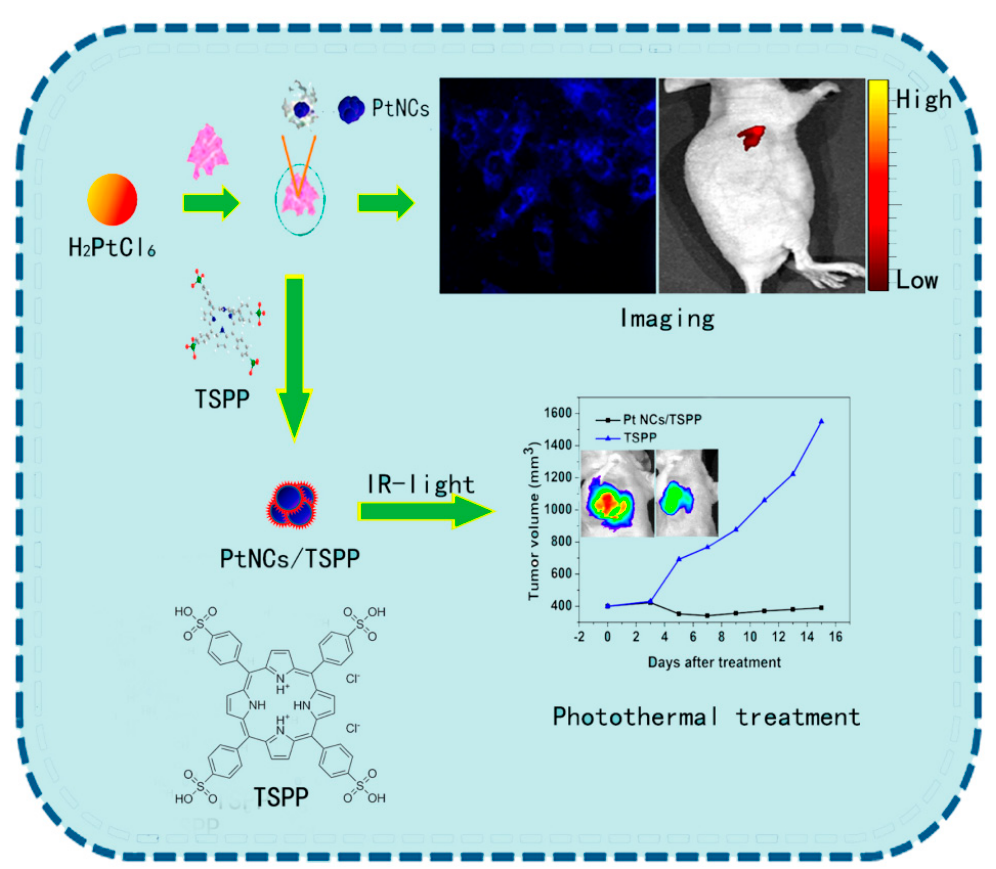
Figure 14. Schematic illustration of the study rationale and design (Copyright Ref [167], American Chemical